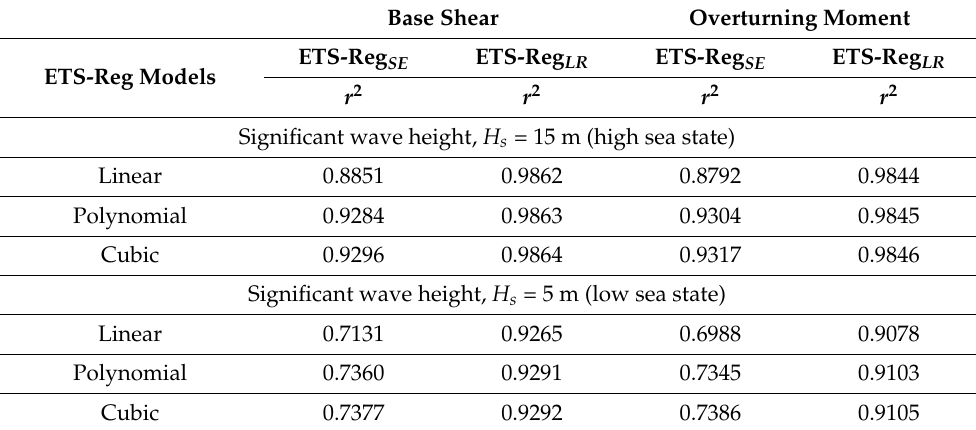
Table 2. Types of ETS-Reg models regarding the coefficient of determination for the low and high sea state ( Hs ) conditions without current ( U = 0.0 m/s) impacts regarding total quasi-static base shear and overturning moment responses.